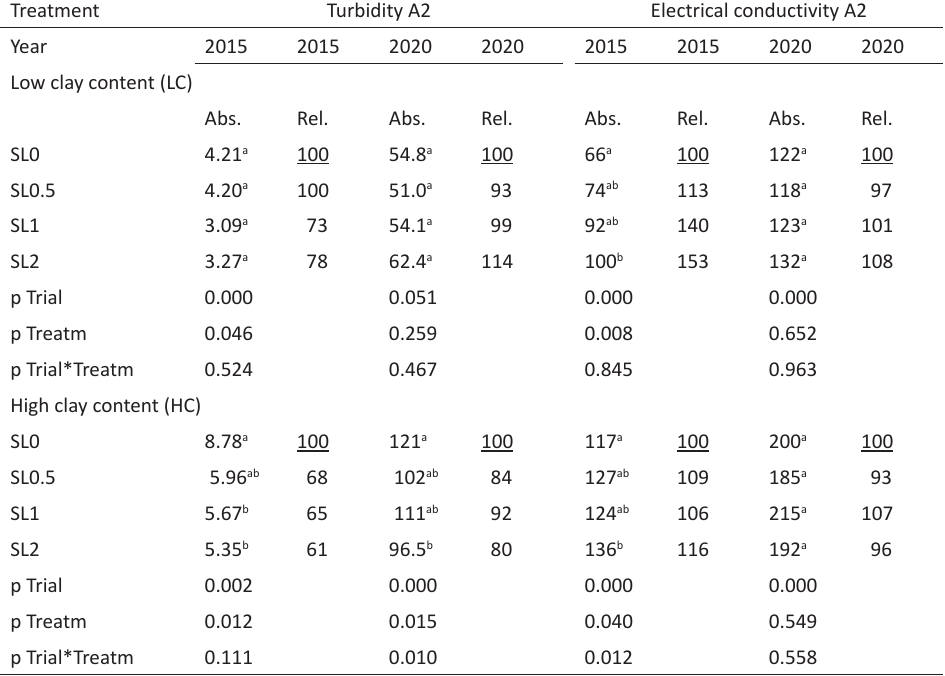
Table 4. Turbidity A2 and electrical conductivity A2 in 2015 and 2020 for the four trials with relative low clay content (LC) and the four with high clay content (HC). Significant differences are indicated by different letters ( p <